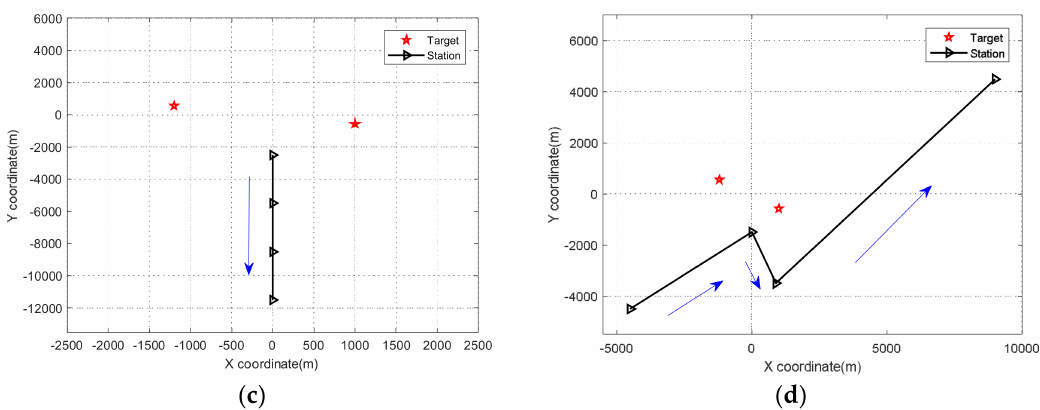
Figure 11. Trajectory of observation movement. ( a ) trajectory around the target sources ( b ) trajectory on one side of the target sources. ( c ) trajectory along the axis of the target sources ( d ) one of the arbitrary movement trajectories.